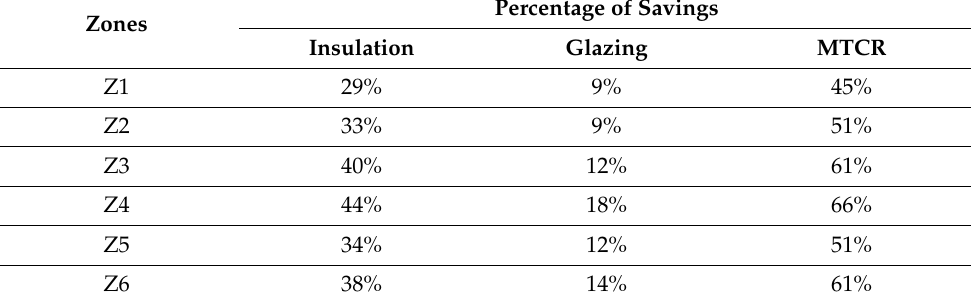
Table 17. Savings rate